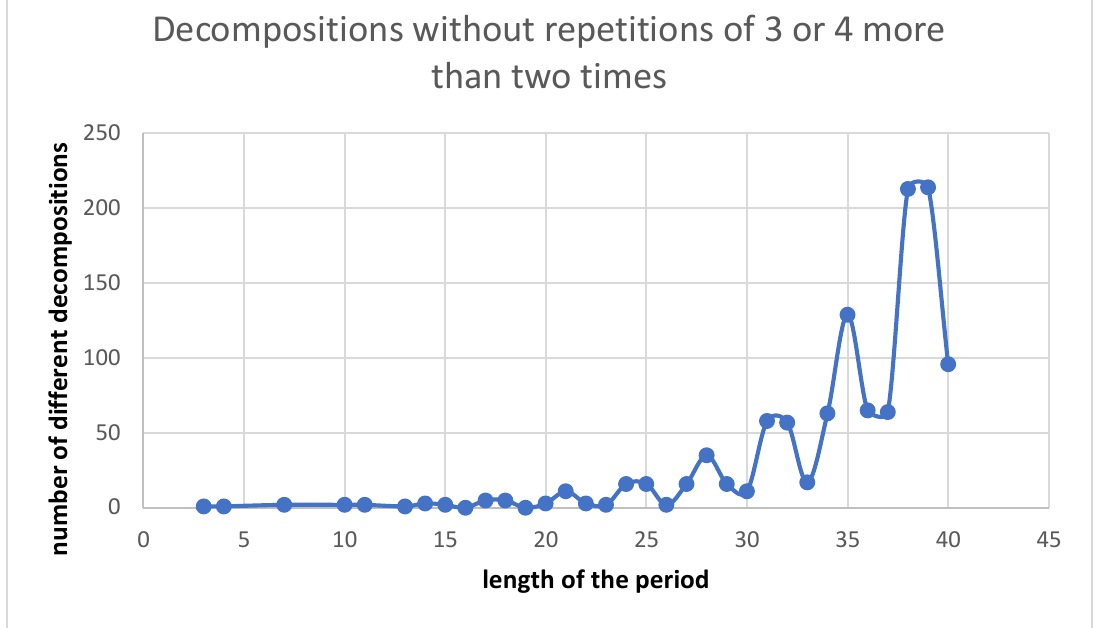
Figure 2 . Decompositions not containing repeats of interhelical contact residue distances of 3 or 4 longer than two.